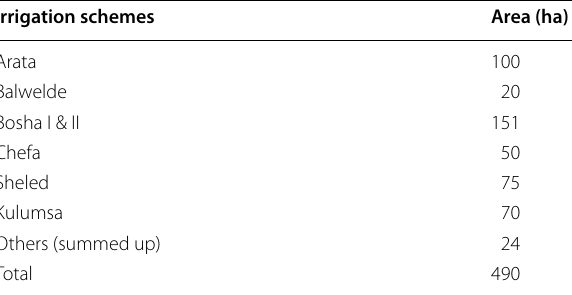
Table 1 List of irrigation schemes in Arata